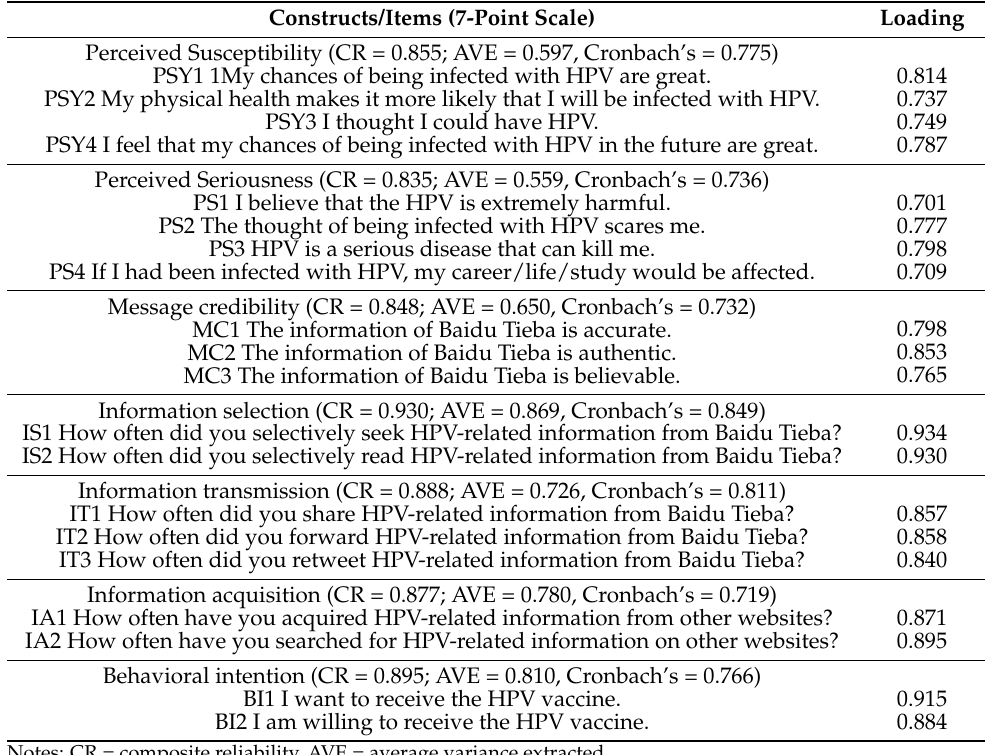
Table 1. Scale items and convergent validity.